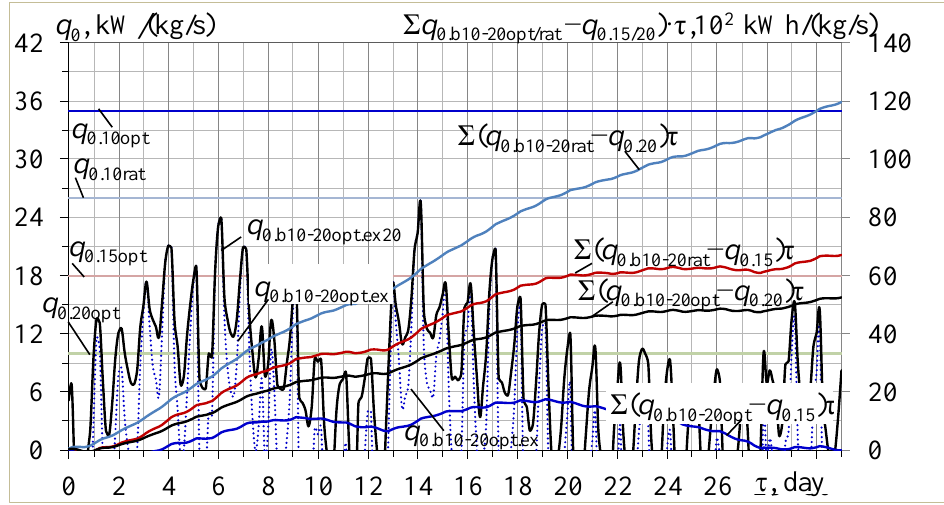
Figure 9. Actual values of booster optimal refrigeration capacity exceedance q 0.b10-20opt.ex over q 0.15 and q 0.b10-20opt.ex20 over q 0.20 ; summarized monthly booster optimal refrigeration energy exceedances Σ q 0.b10-20opt.ex τ over q 0.15 and Σ q 0.b10-20opt.ex τ over q 0.20 ; summarized data on booster rational refrigeration energy Σ q 0.b10-20rat.ex τ over q 0.15 and Σ q 0.b10-20rat.ex20 τ over q 0.20 : q 0.b10-20opt.ex = q 0.b10-20opt − q 0.15 ; q 0.b10-20opt.ex20 = q 0.b10-20opt − q 0.20 ; Σ q 0.b10-20opt.ex τ = Σ ( q 0.b10-20opt − q 0.15 ) τ ; Σ q 0.b10-20opt.ex τ = Σ ( q